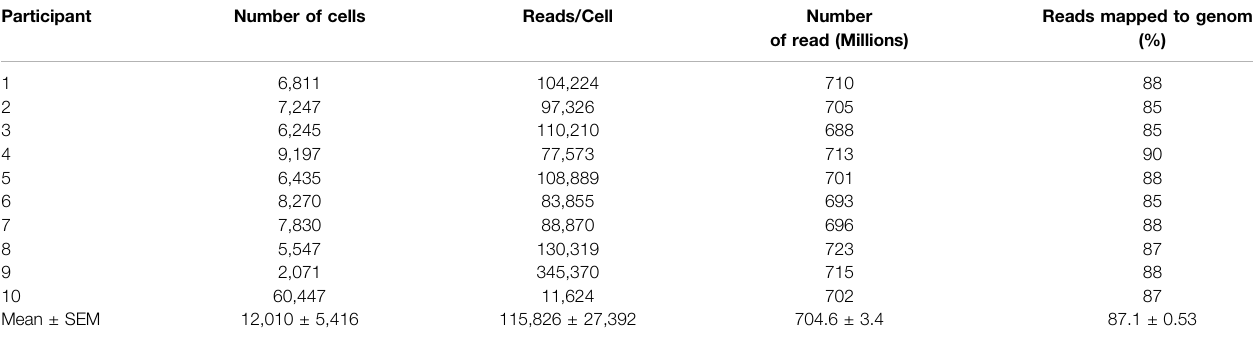
TABLE 1 | Summary of Data Generation from scRNAseq of FACS-isolated Human Colonic Epithelial Cells Originating from Cryopreserved Biopsies. Participant Number of cells Reads/Cell Number